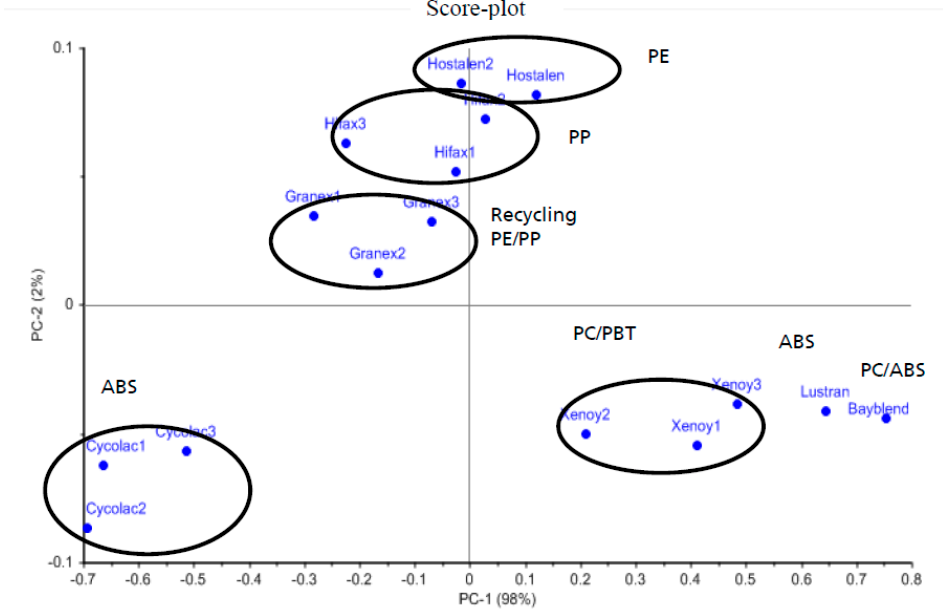
Figure 6. PC1–PC2 plot of the scores from principle component analysis (PCA) evaluation of the black plastic samples. Each dot in the plot in Figure 6 represents a complete spectrum.